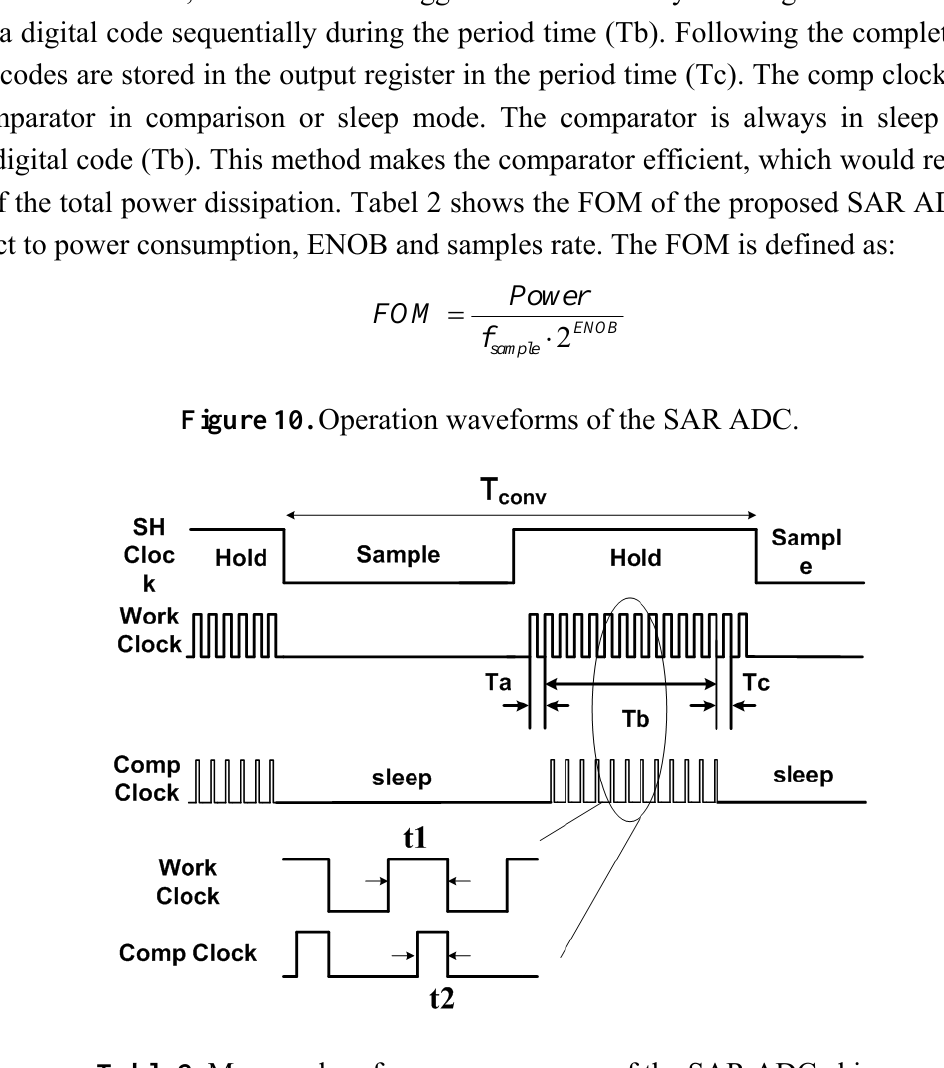
Table 2. Measured performance summary of the SAR ADC